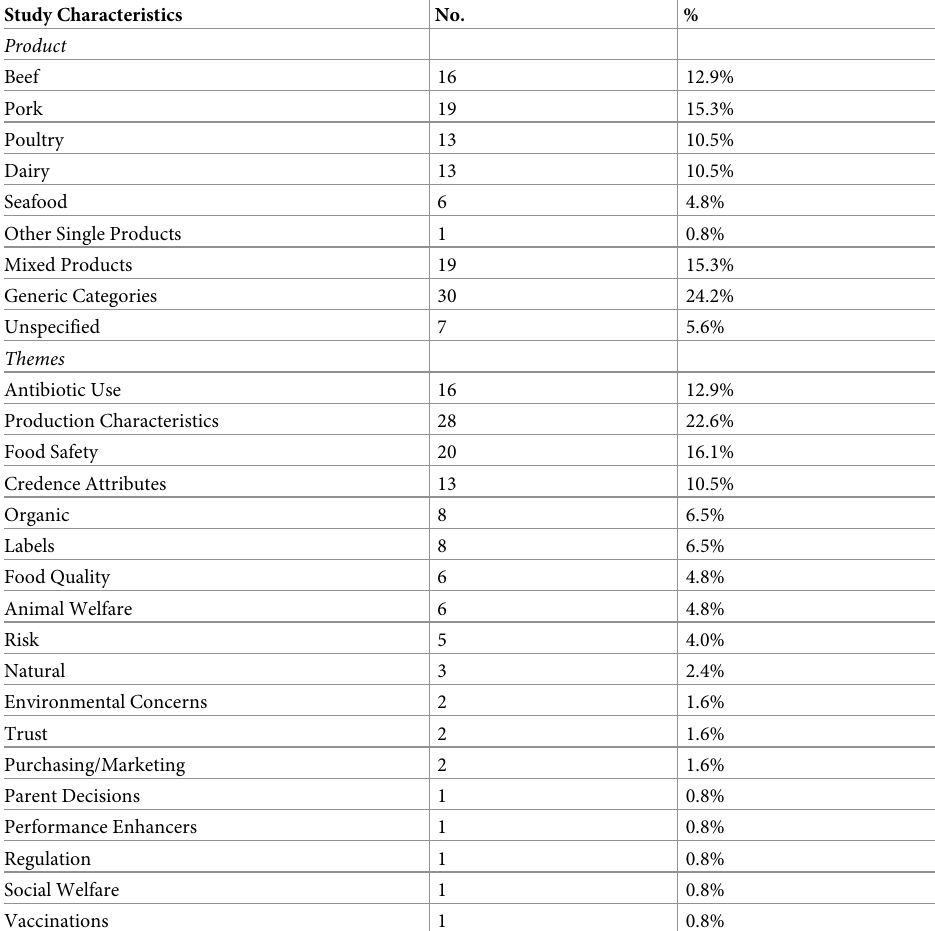
Table 2. Product and theme focus of extracted texts.